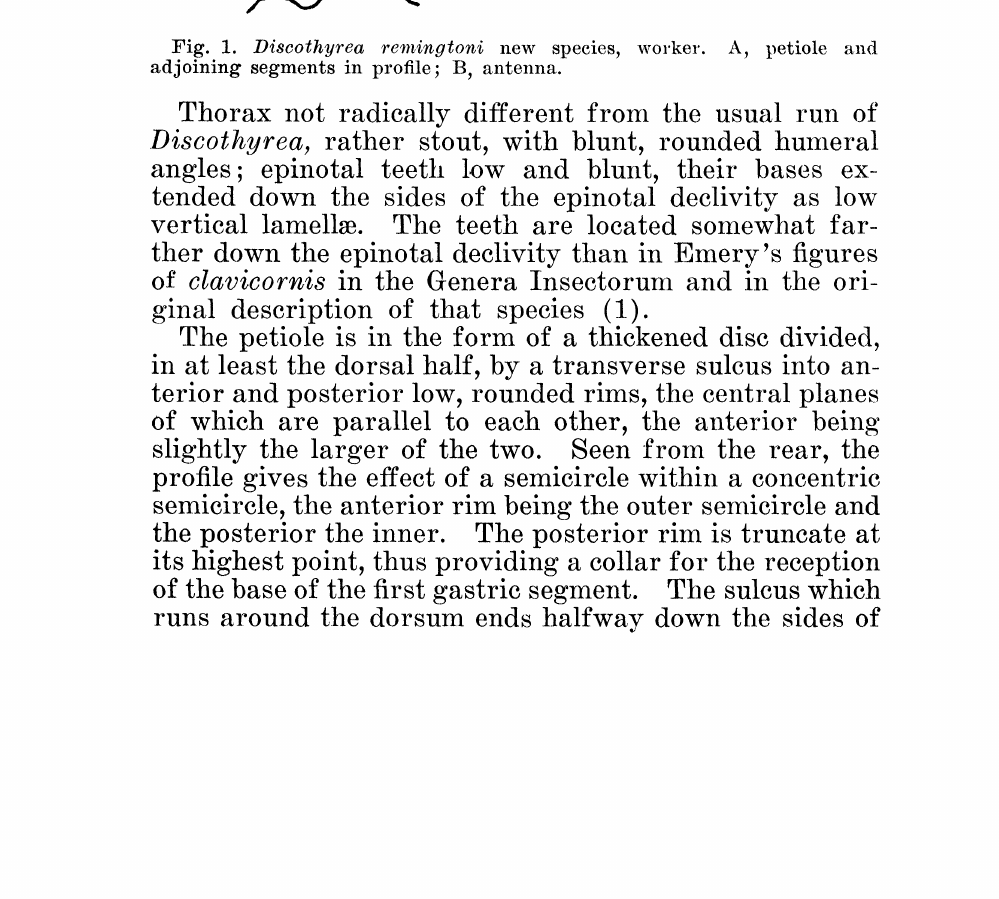
Fig. 1. Discothyrea remingtoni new species, worker. A, petiole and adjoining segments in profile; B,